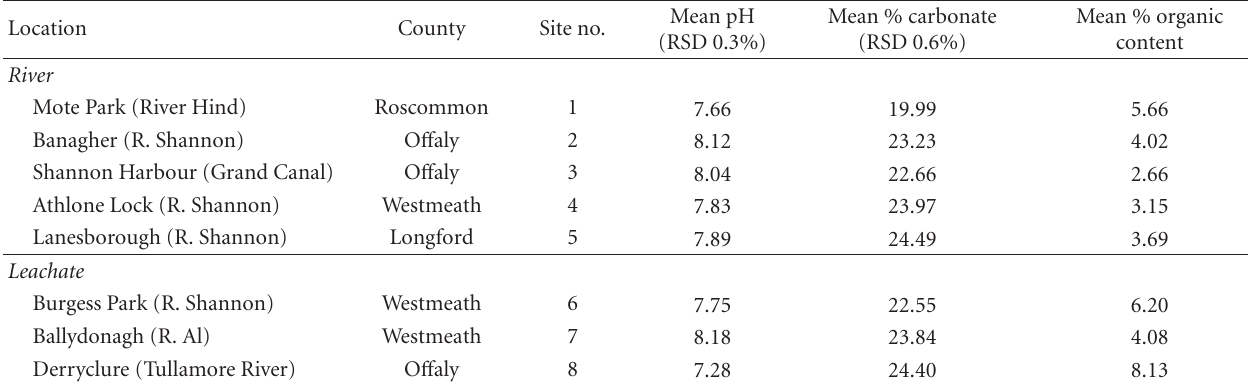
Table 2: Average values for master variables over a six-month period for the river sediments and leachate sediment, 2004-2005.